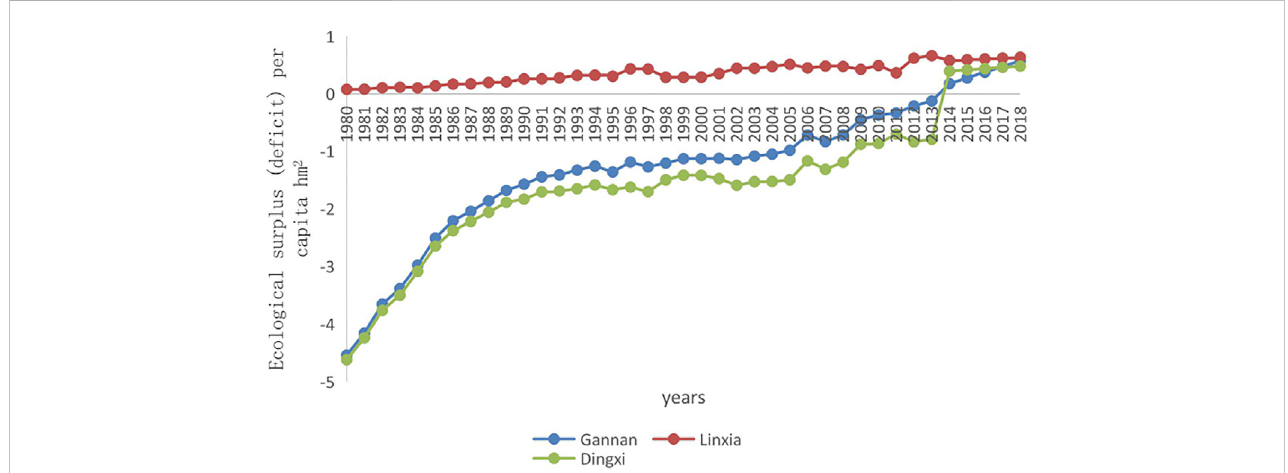
FIGURE 4 Comparison of per capita ecological surplus of the three regions from 1980 to 2018.